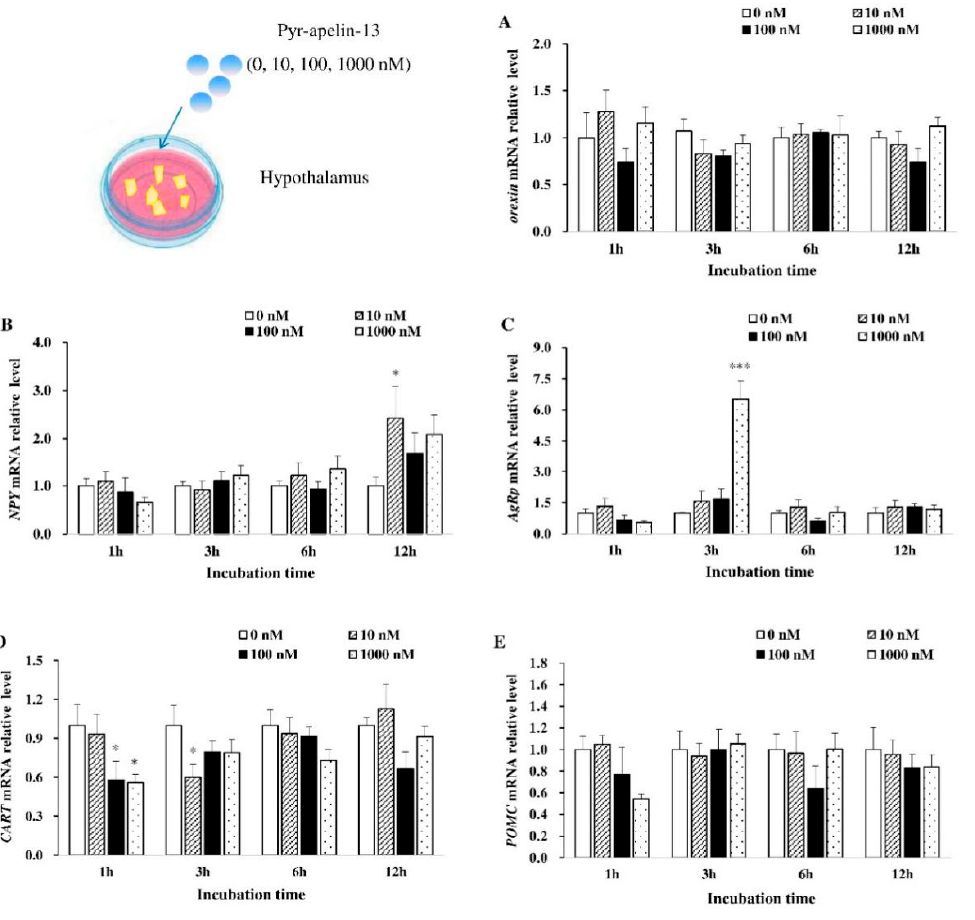
Figure 1. E ff ects of Pyr-apelin-13 (0, 10, 100, and 1000 nM) on mRNA expressions of appetite-related genes in Cyprinus carpio L. hypothalamic fragments. Orexin ( A ), NPY ( B ), AgRP ( C ), CART ( D ), POMC ( E ). Differences between treatment and control groups at each time point were tested